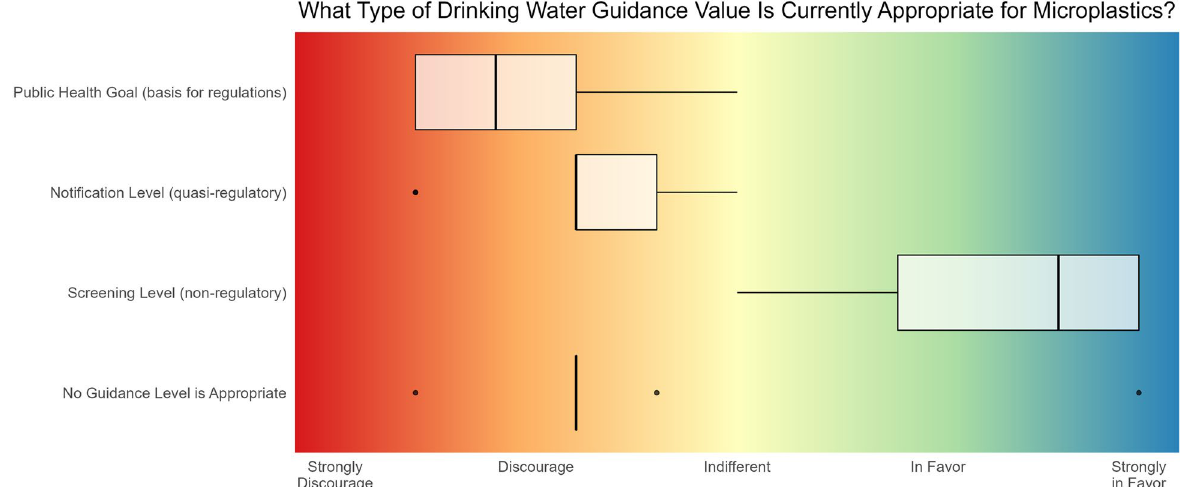
Fig. 3 Results from the polling of workshop participants in relation to an appropriate health-based threshold level that the California State Water Resources Control Board should adopt for MPs in drinking water. Results presented are based on the experts’ qualitative judgement of the evidence of health effects obtained from the studies evaluated through the Tiered approach presented in this study. The box and whiskers plot represents the summary of votes ( n 9), with the upper and lower boundaries of the box indicating the 75th and 25th percentiles, respectively. The line within = the box marks the median, error bars indicate the 90th and 10th percentiles, and individual points represent statistical